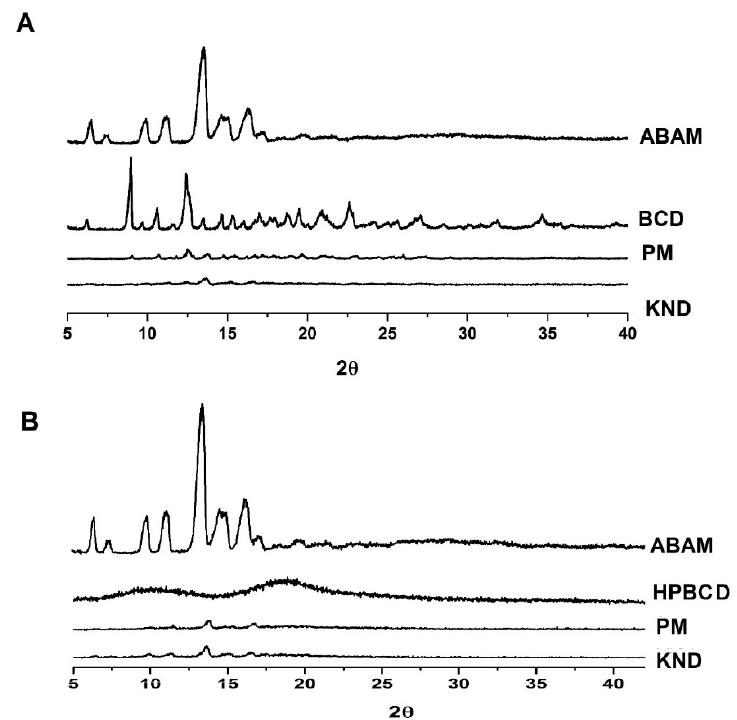
Figure 3. X-ray di ff raction patterns of ABAM and its ICs. ( A ) β CD alone and as ABAM- β CD obtained Figure 3. X ‐ ray diffraction patterns of ABAM and its ICs. ( A ) β CD alone and as ABAM ‐β CD obtained by PM and KND, ( B ) HP β CD alone and as ABAM-HP β CD obtained by PM and by PM and KND, ( B ) HP β CD alone and as ABAM ‐ HP β CD obtained by PM and KND.